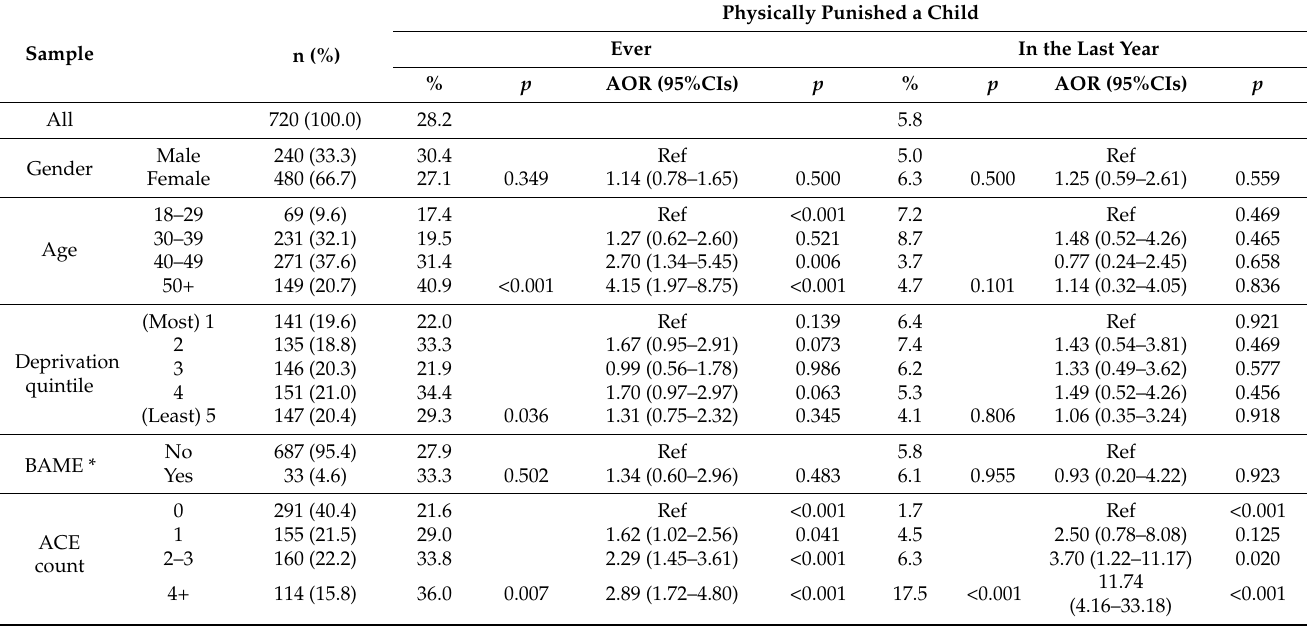
Table 1. Participant characteristics and bivariate and multivariate associations with child physical